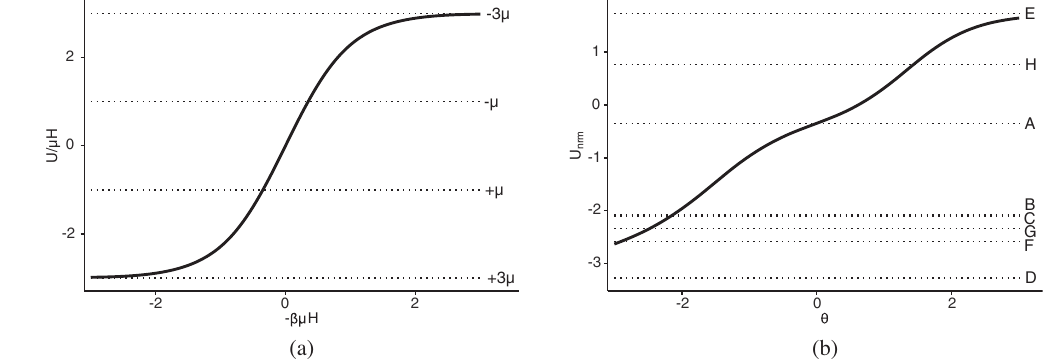
FIG. 4. (a) Average energy U for the three-particle spin- 1 = 2 paramagnet, plotted as a function of the temperature parameter − β . All axes have been scaled to obtain dimensionless quantities. The dotted lines show the energy value for each macrostate, labeled by magnetization. (b) The IRT equivalent of average energy U plotted as a function of the latent trait θ for item 14 of the FMCE. The nrm dotted lines show the a energy value for each response k; 14